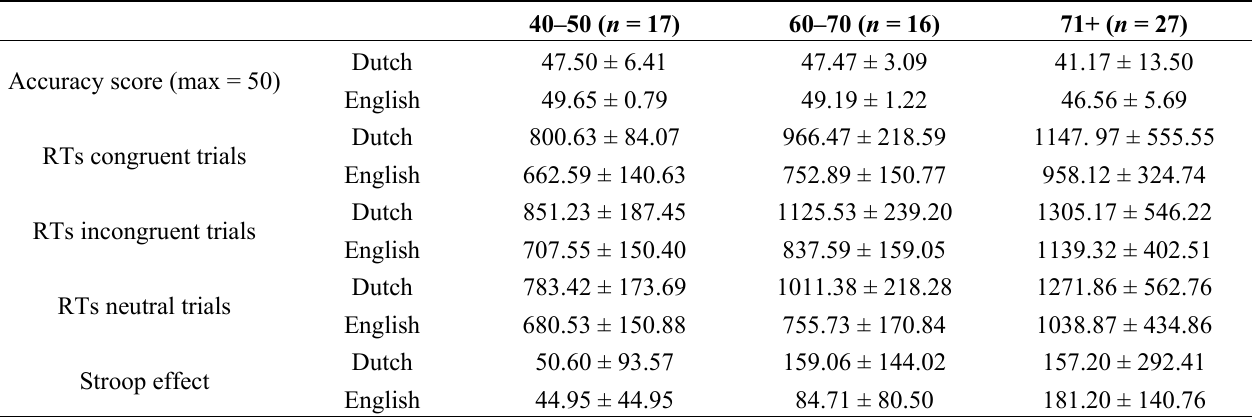
Table 4. Mean reaction times (and SDs) on the L1 and L2 Stroop Tasks, split per age